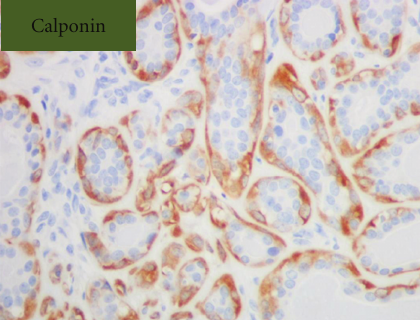
Figure 5: Myoepithelial stains, calponin, (original magnification ×